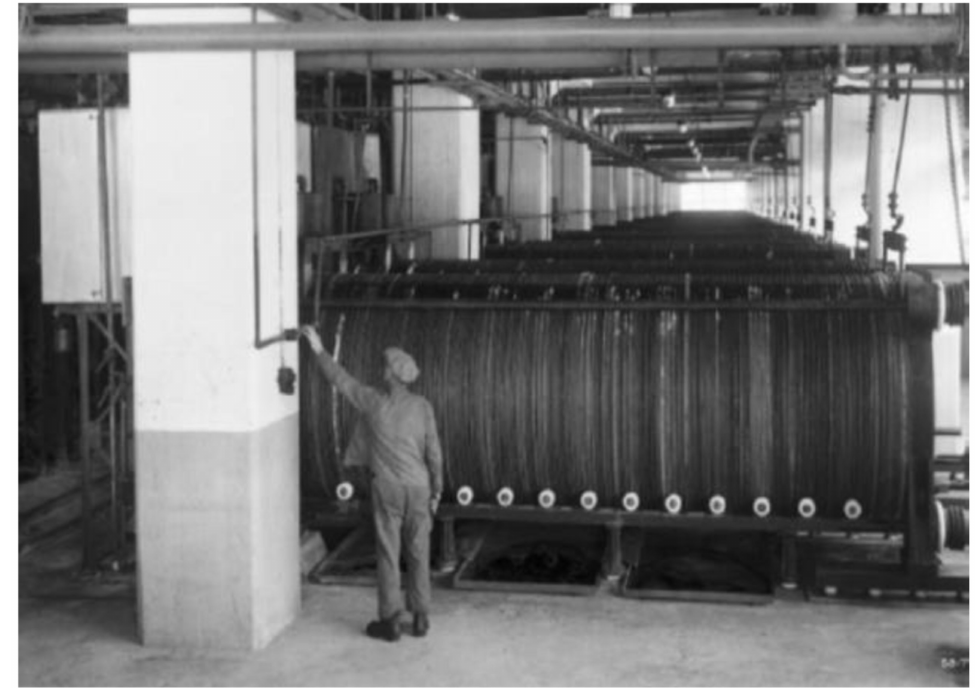
Figure 7. Electrolyzers at the Rjukan ammonia factory in Norway, operational 1928–1971. Courtesy Norsk